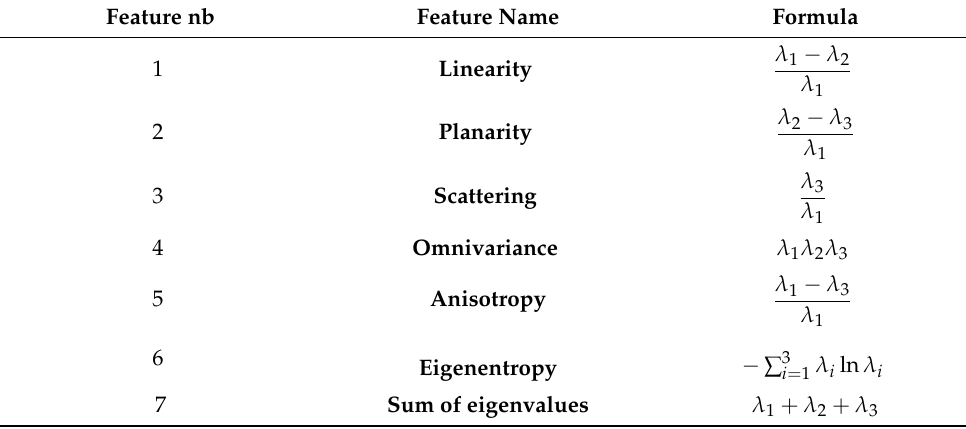
Table 1. Geometric features of a point p 0 with coordinates (x, y, z). k n is the number of nearest neighboring points. λ are the eigenvalues of the covariance matrix built from the k n points per descending order. Z refers to the z-coordinate, d r is the distance between the reference point and the best fitting plane computed on its nearest neighbors. r max denotes the distance of the farthest point from the reference point among the k n neighboring